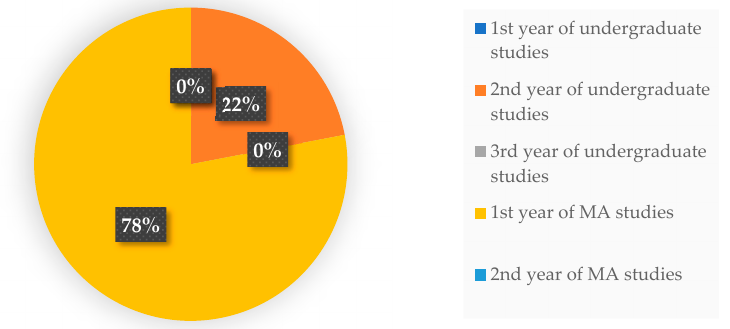
Figure 8. Experience in the work with ADPIECare system application by the surveyed users during undergraduate (BSN) and MA studies (MZ).